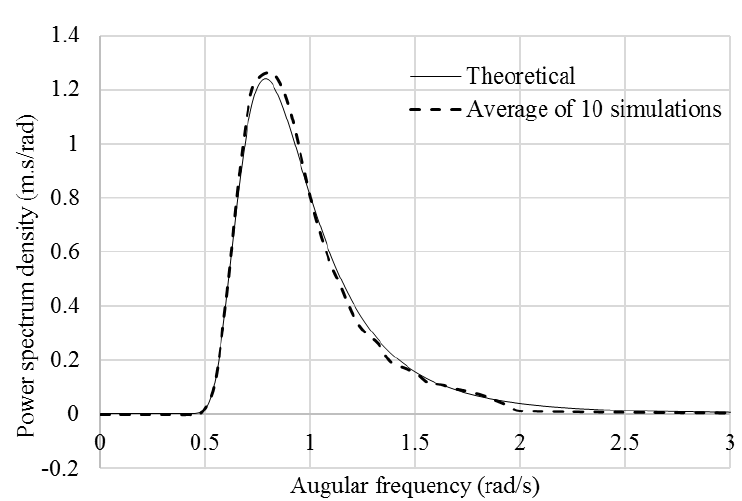
Figure 16. Power spectral density of surface elevation.